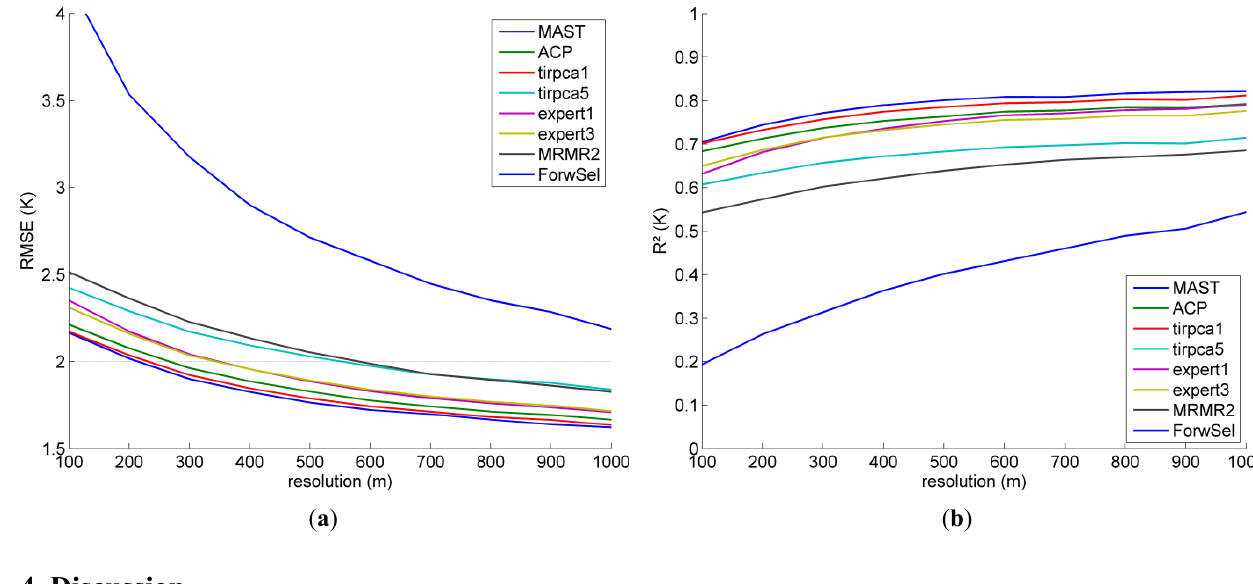
Figure 3. Resolution dependent performance of the downscaling scheme for